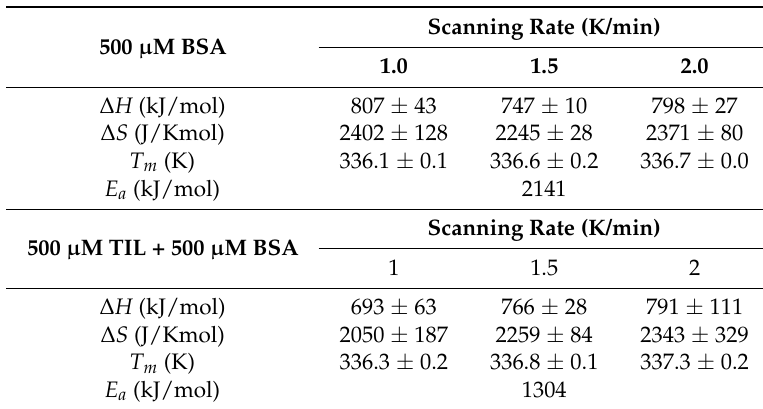
Figure 4. Representative DSC curves of BSA in the absence and presence of TIL and the Kissinger’s plots of the kinetic parameters. Table 3. Scan rate-dependence of transition temperature and the related enthalpy change, entropy change and the activation energies associated with the unfolding of BSA in the absence and in the presence of